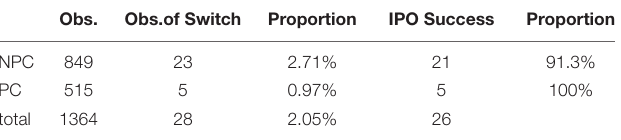
TABLE 3 | Distribution